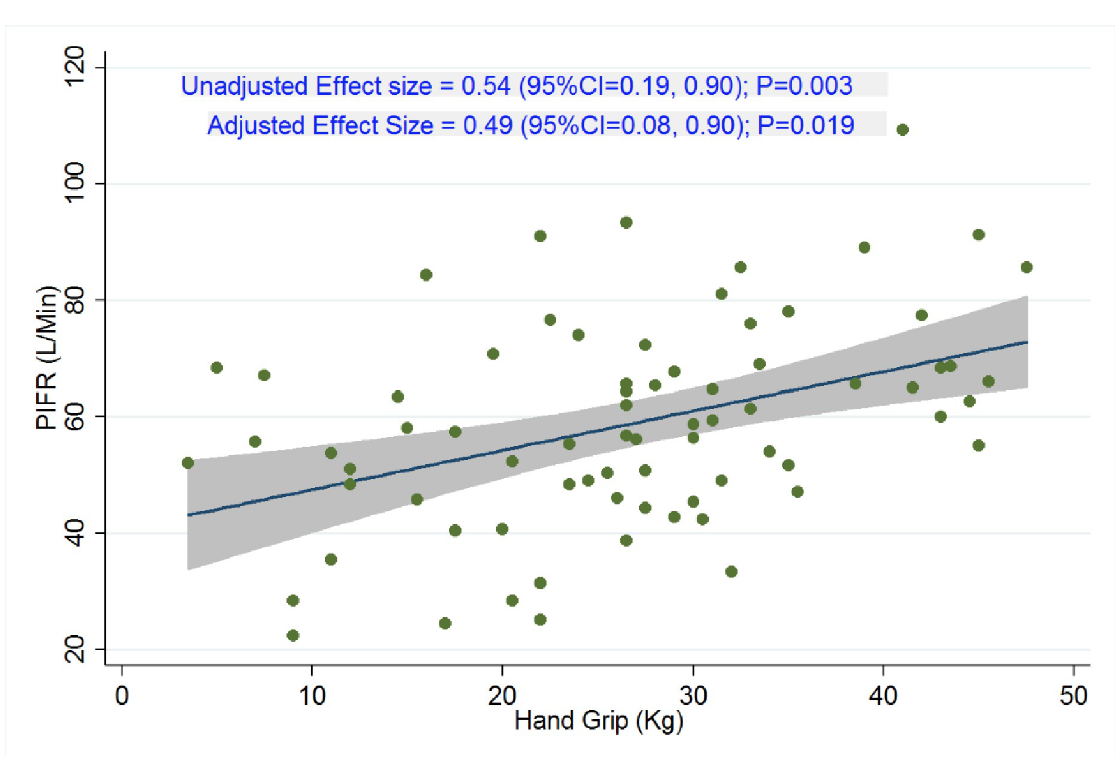
Fig 2. Association between peak Inspiratory flow rate (PIER, L/min) and Hand Grip Strength(HGS, kg) as continuous variables.